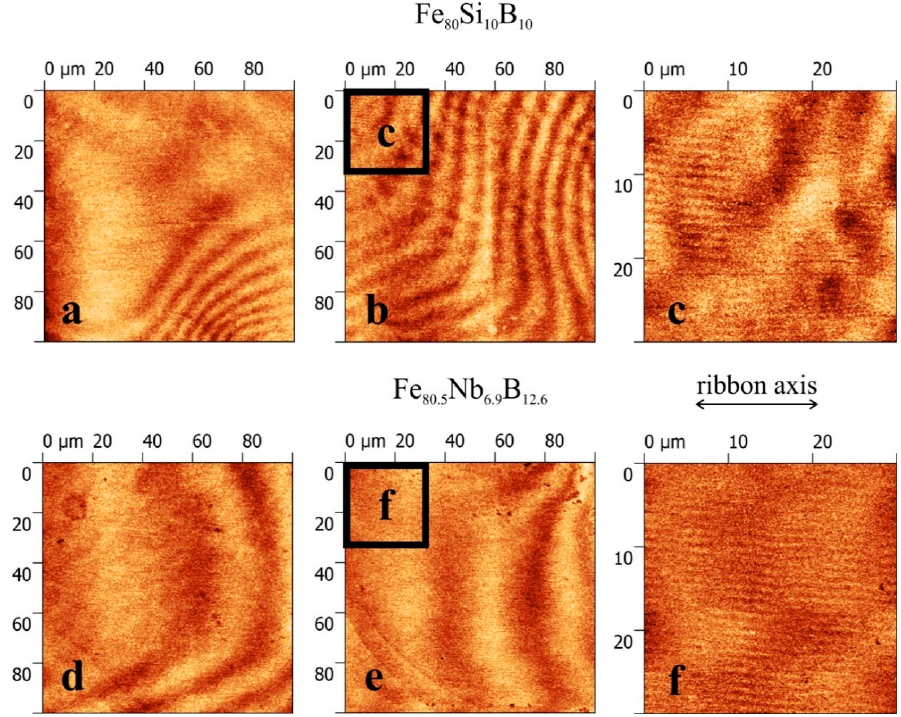
Figure 7. Magnetic force microscopy images of domains observed on the surfaces of Fe 80 Si 0 B 10 (top) and Fe 80.5 Nb 6.9 B 12.6 (bottom) ribbons. Patterns are shown at two different surface areas with dimensions 100 × 100 µm 2 ( a , b and d , e ). Subplots c and f present details (30 × 30 µm 2 ) of images ( b ) and ( e ), respectively.